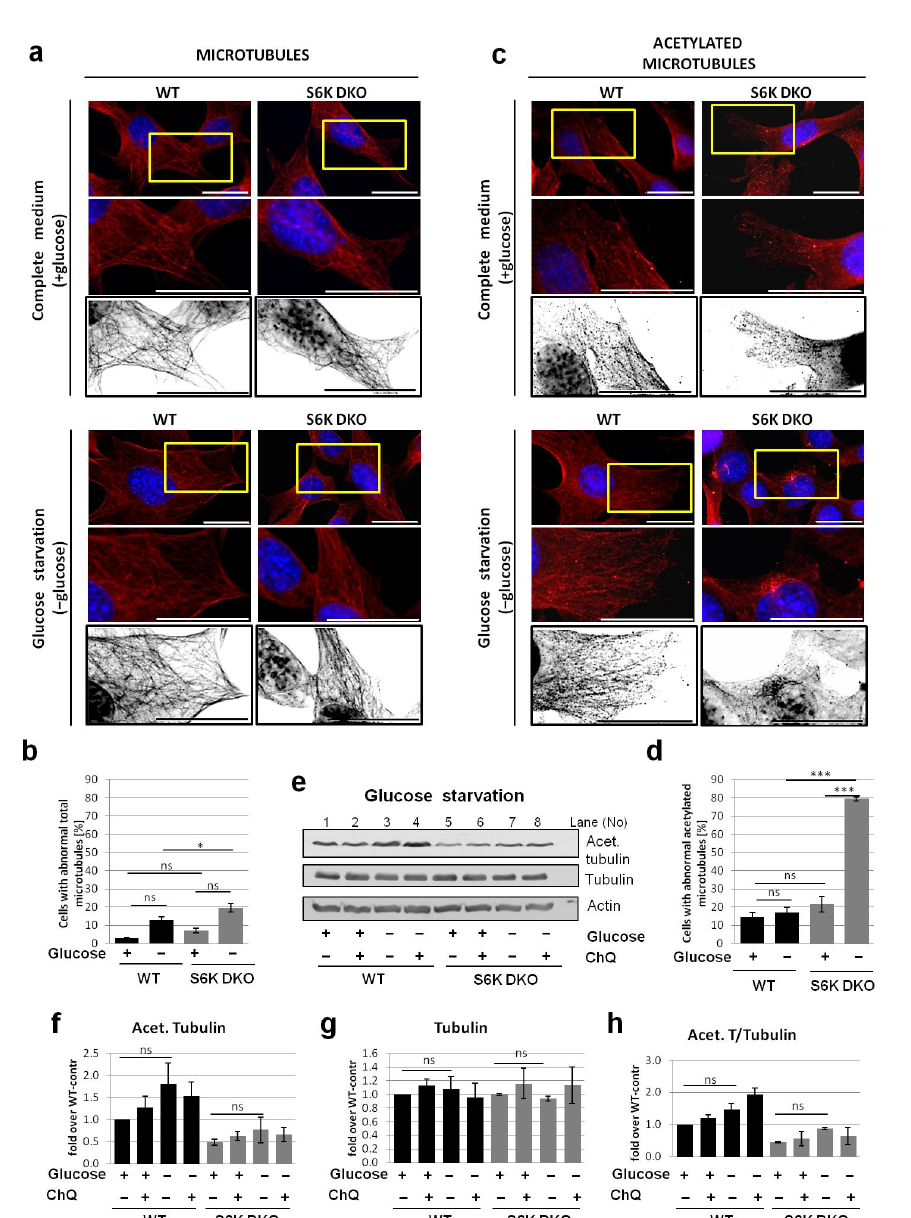
Figure 6. Lack of S6K affects the acetylated but not the total microtubule network in glucose-starved cells. Total ( a,b ) and acetylated ( c,d ) microtubule network was investigated by immunofluorescent staining of total α -tubulin ( a ) or acetylated tubulin ( b ), respectively, in WT and S6K DKO (DKO) MEF grown in a complete medium (control; +glucose) or deprived of glucose ( − glucose) for 6 h. The cells were stained using mouse antibodies against α -tubulin ( a ) or acetylated tubulin (Lys40) ( b ), followed by staining with goat anti-mouse–TRITC conjugates. DNA was stained with DAPI (blue). The indicated sections of original images are shown enlarged (middle panels) and, for clarity, deconvoluted and transformed into inverted grey scale (bottom panels). Representative images of cells analyzed in at least 10 random fields per experiment are shown. Scale bar = 25 µ m. Approximately 100 cells per sample were counted in three independent replicates. The percentage of cells with a diffused, depolymerized (abnormal) microtubule ( b ) and acetylated microtubule ( d ) network was counted and graphed (mean ± SEM). Statistical significance was determined by one-way ANOVA followed by Bonferroni’s multiple comparison test: *** p < 0.001; ns, not significant. ( e ) Acetylated tubulin and total α -tubulin levels were evaluated by western blotting in WT and S6K DKO MEF grown in a complete medium (control; +glucose) or a medium deprived of glucose for 3 h ( − glucose). The blots were re-probed with anti- β -actin antibodies to ensure equal protein loading. Densitometric data, of acetylated tubulin ( f ) and tubulin ( g ) levels, corrected for loading control, as well as acetylated tubulin to total tubulin ratio ( h ) are presented as a fold-change from the reference, the control WT MEF ( lane 1 ). The experiment was performed in three independent replicates. The data are shown as the mean ± SEM. The statistical significance of differences was determined by one-way ANOVA followed by Bonferroni’s multiple comparison test: * p < 0.05, *** p < 0.001; ns, not